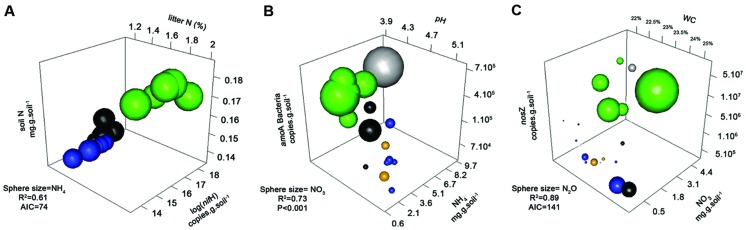
3-D bubble plots based on univariate data to explain the products NH4+ (A), NO3- (B), and N2O Flux (C). The axes are the predictor variables and the sphere sizes the respective products. For each graph, its significance was tested by a regression analysis, reporting its R2 and significance (P or AIC). Data are shown for four different land use types, forest (green), pasture (black), soybean 25 years (blue), soybean 2 years (orange squares, and adjacent forest in gray).